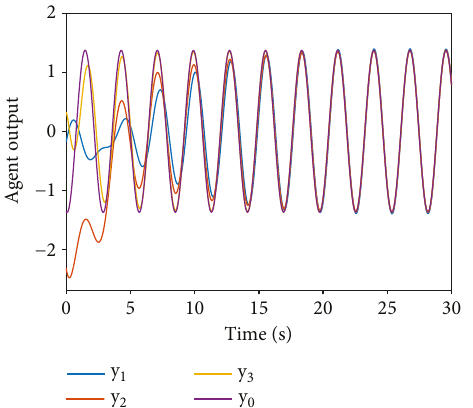
Figure 2: The follower output y state-feedback control (6).